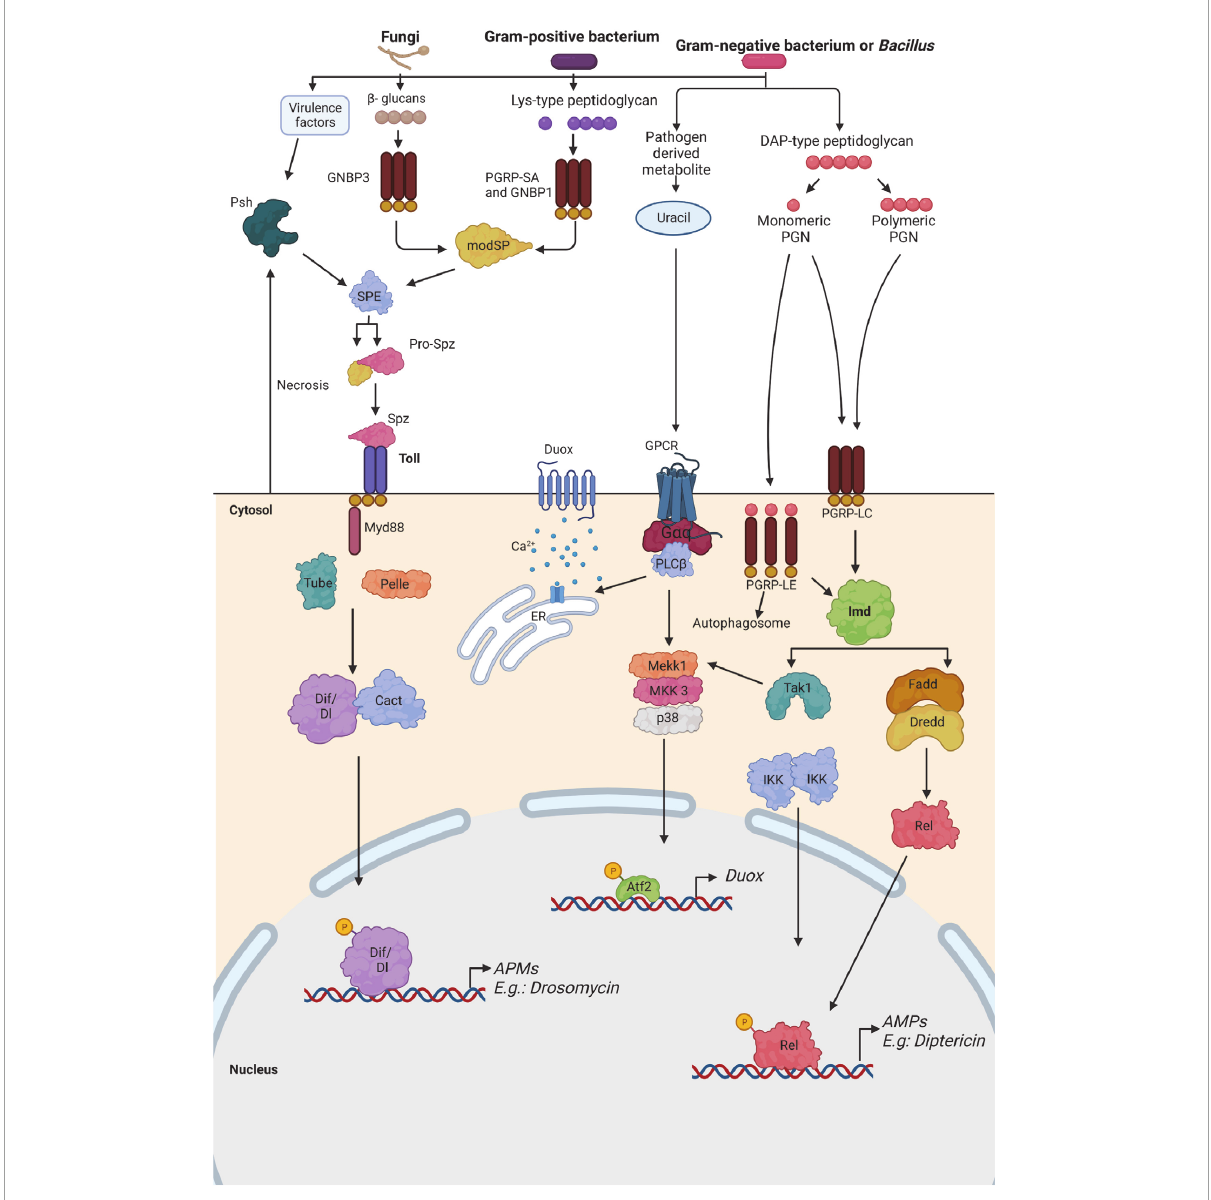
FIGURE2 Immune recognition of microorganisms in Drosophila . The two major pathways that sense bacteria and fungi in fruit flies are the Toll pathway (left) and the immune deficiency (Imd) pathway (right). Both pathways function in the fat body for the production of antimicrobial peptides (AMP) by activating the expression of NF- κ B-like factors, which are highly conserved among species. In addition, the Imd pathway also functions in the epithelial surfaces. The Imd pathway is activated when DAP-type peptidoglycan from gram-negative bacteria, and some gram-positive, binds to Peptidoglycan Recognition Proteins (PGRPs), and this activation leads to the generation of AMP and synthesis of Duox enzyme for the production of reactive oxygen species (ROS). Gram-positive bacteria contain lys-type peptidoglycan, which is recognized by PGRP-SA and Gram Negative Bacteria Protein (GNBP) 1, and GNBP3 binds to β -glucans of yeasts and fungi, leading to the activation of the Toll pathway. This pathway can also be triggered by danger signals like proteases or abnormal cell death that activates the protease Persephone (Psh). In all cases, the activation of the Toll pathway triggers a proteolytic cascade that activates the protease Spätzle- processing enzyme (SPE). This protein will cleave Spätzle (Spz). As a result of the activation of the Toll pathway, the transcription factors Dorsal-related immunity factor (Dif) or Dorsal (Dl) will translocate to the nucleus, thus inducing the expression of AMP genes like drosomycin . Similarly, the activation of the Imd pathway induces the nuclear translocation of the transcription factor Relish (Rel) and induction of the expression of AMP genes, such as diptericin . The generation of ROS is induced by the activation of Duox in the presence of uracil. This is caused by the activation of a G protein-coupled receptor (GPCR), which promotes the release of calcium from the endoplasmic reticulum. This signaling pathway, together with the activation of the Imd pathway, contributes to the expression of the Duox enzyme during infection. Atf2, activating transcription factor 2; Dredd, death-related ced-3/Nedd2-like caspase; Fadd, FAS-associated death domain ortholog; G α q, G protein α q-subunit; IKK, inhibitor of NF- κ B kinase; MKK3, MAPK kinase 3; modSP, modular serine protease; Tak1, TGF β -activated kinase 1. Adapted from Buchon et al. (2014) and Younes et al.